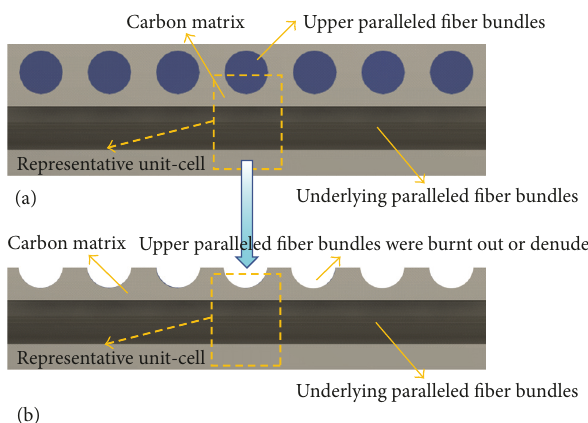
Figure 5: Representative unit-cell of the C/C composites with a single paralleled fiber (Direction